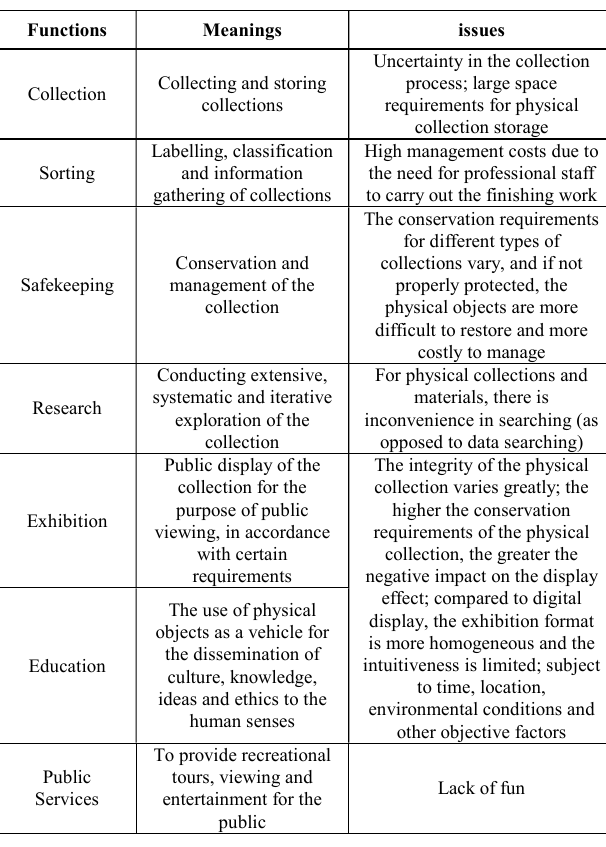
Table 2. Functional analysis of traditional museums.